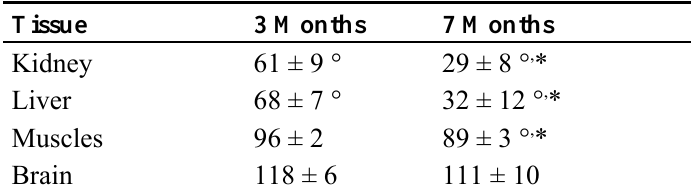
Table 4. Contribution of the methylated form of mercury in tissues from mice fed an aimara-containing diet for 7 months a